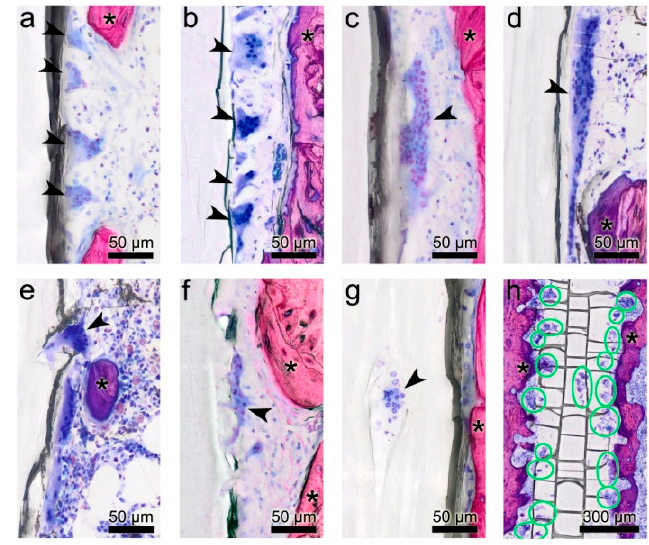
Figure 4. Morphological diversity of multinucleated giant cells (MGCs). ( a – d ) MGCs of various shape, size, numbers of nuclei and different staining intensities adhere to the surface of the poly(lactide-co-glycolide) (PLGA) implant in both, the PLGA and PLGA + DS8 groups. ( d ) Large MGC with a length of 270 µm. ( e , f ) MGCs submerge into the PLGA implant by extruding filopodia. ( g ) MGC located in a lacuna within the PLGA implant. ( h ) Overview section parallel to the midsagittal plane of a PLGA implant illustrating the location and activity of MGCs below the surface of a PLGA + DS8 rod 6 weeks after surgery (green circles indicate MGCS). Arrowheads point to multinucleated giant cells; Asterisks indicate bone.